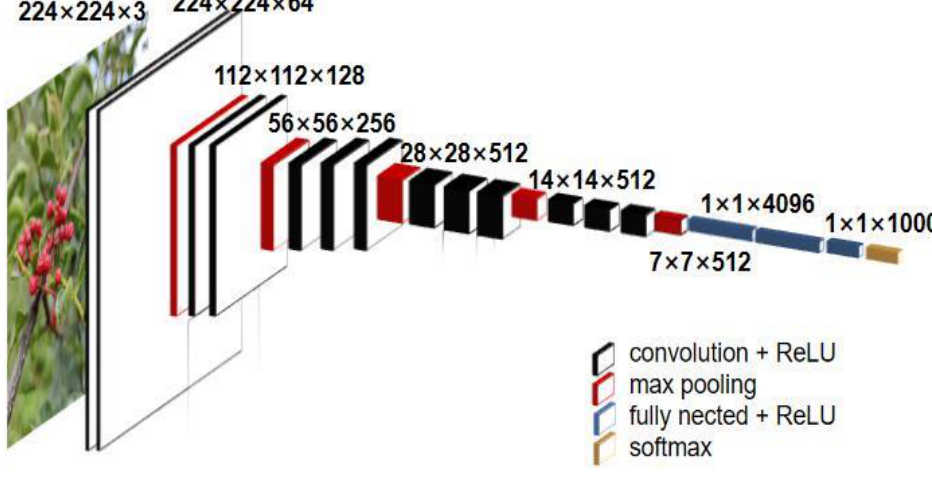
Figure 6. The VGG Figure 6. The VGG model. Figure 6. The VGG model.